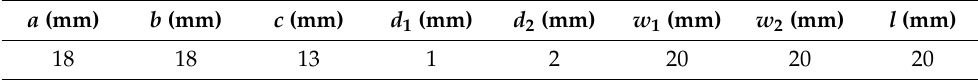
Figure 2. ( a ) Unit cell of a dual-band AMC where the electromagnetic waves are incident from port 1 to port 2. ( b ) Hierarchical diagram of the designed dual-band AMC. Table 1. Critical dimensions of the designed dual-band AMC. Table 1. Critical dimensions of the designed dual-band